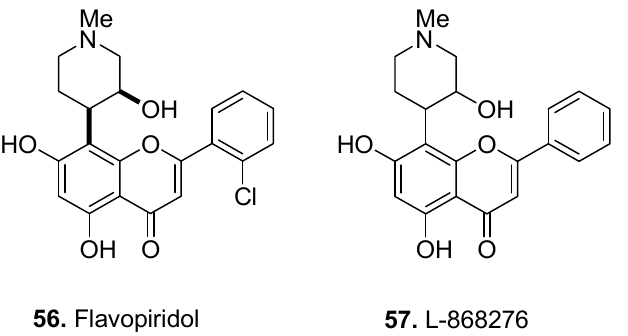
Figure 23. Bioactive semi-synthetic flavoalkaloids: Flavopiridol ( 56 ) and L -868276 ( 57